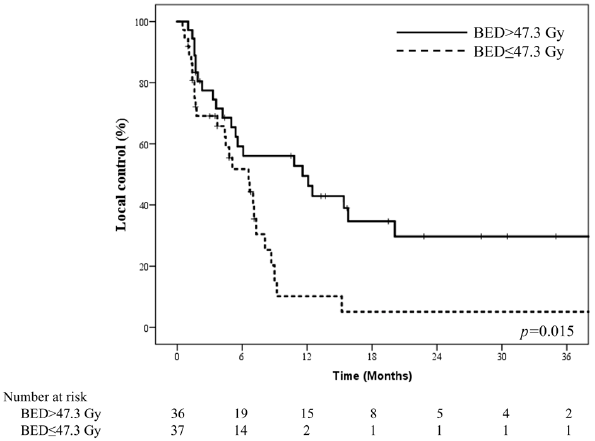
Figure 3. The difference in LC regarding BED10 of 47.3 Gy (equivalent to 35 Gy in 10 fractions) suggests the plausibility of dose escalation in patients who require RT with well-preserved liver